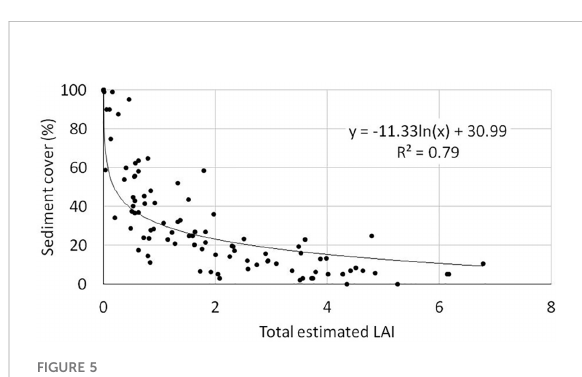
FIGURE 5 Relationship between total estimated LAI and bottom sediment cover